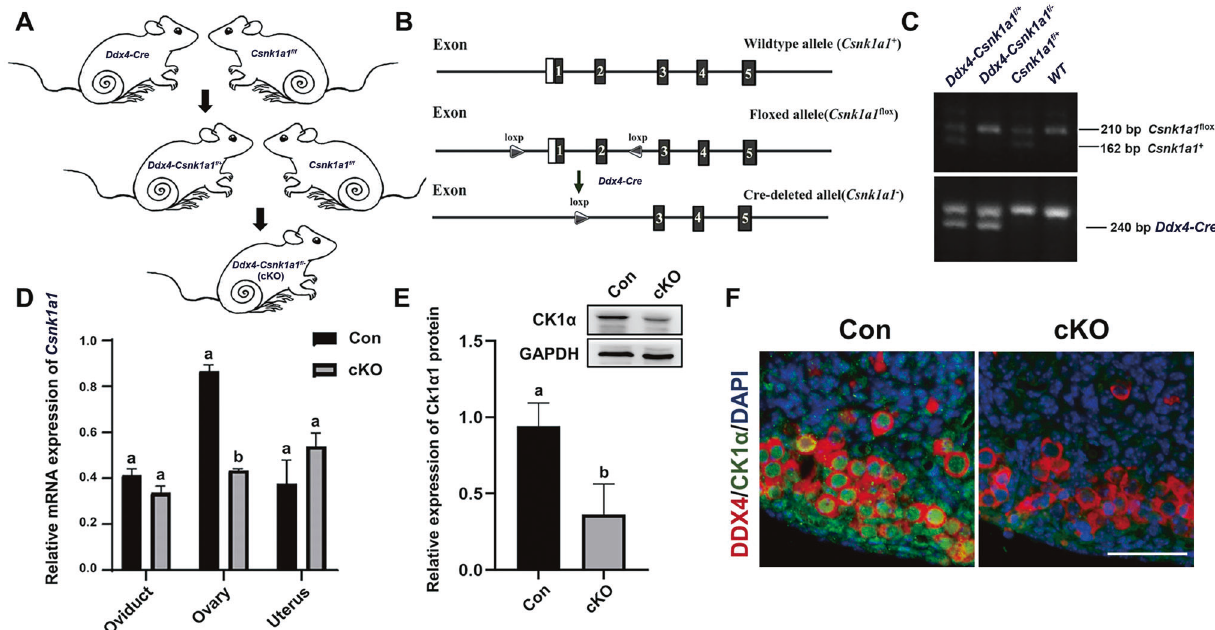
Fig. 2 Establishment of oocyte-speci fi c Csnk1a1 deletion mouse model. A , B Simpli fi ed strategy for creating Csnk1 α 1 conditional knockout mouse. C Genotype of Ddx4-Cre and Csnk1 α 1- fl oxp assayed by PCR. D Csnk1 α 1 mRNA levels in the ovaries, oviducts and uteri of 1 dpp mice and E Representative image of western blot detecting the knockdown ef fi ciency of CK1 α protein and the relative protein levels were normalized to GAPDH ( n = 3). Different letters represent signi fi cant difference ( P < 0.05). Data are shown as mean ± SEM. F Representative images of dual immuno fl uorescence staining of DDX4 (oocyte marker, red) and CK1 α (green) on 1 dpp cKO and control mouse ovaries. DAPI (blue): DNA. Scale bars: 50 μ